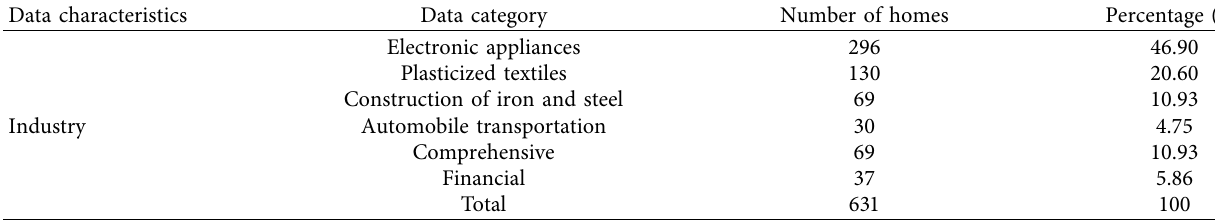
Table 3: Number of industrial types.